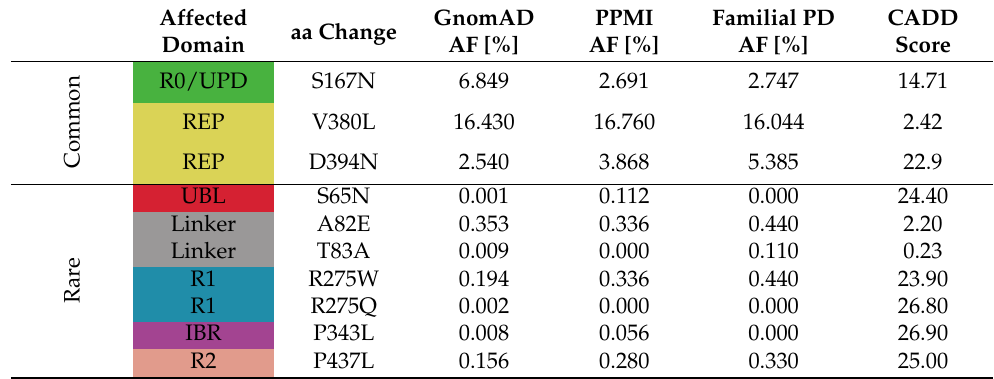
Table 1. Common and rare variants in PRKN . Common (>1%) and rare variants (<1%) in PRKN are listed together with their color-coded domain, the caused amino acid change and the allele frequencies (AF) in GnomAD, the PPMI cohort and a familial PD cohort. Shown is also the CADD score, a computational prediction for the deleteriousness of the mutation. CADD scores were generated with GRCh38